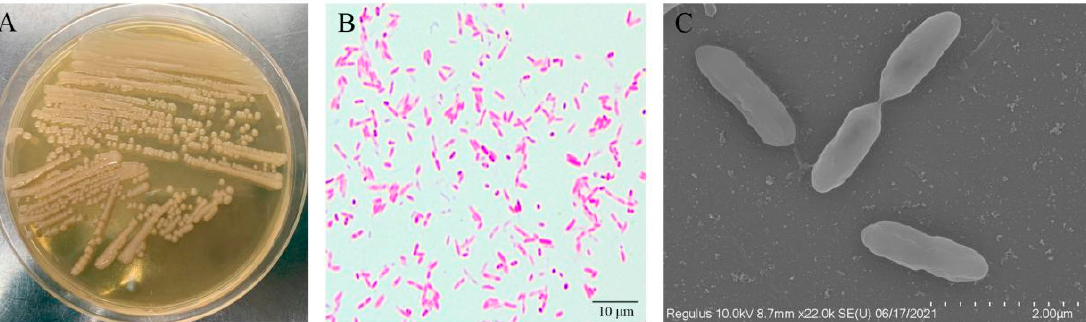
Figure 2. Colonial morphology, Gram staining and scanning electron microscopy image of the isolate WH21406. ( A ) Colonial morphology of WH21406, ( B ) Gram staining image of WH21406, ( C ) Scanning electron microscopy image of WH21406. Table 2. Results of Biolog identification of strain WH21406.